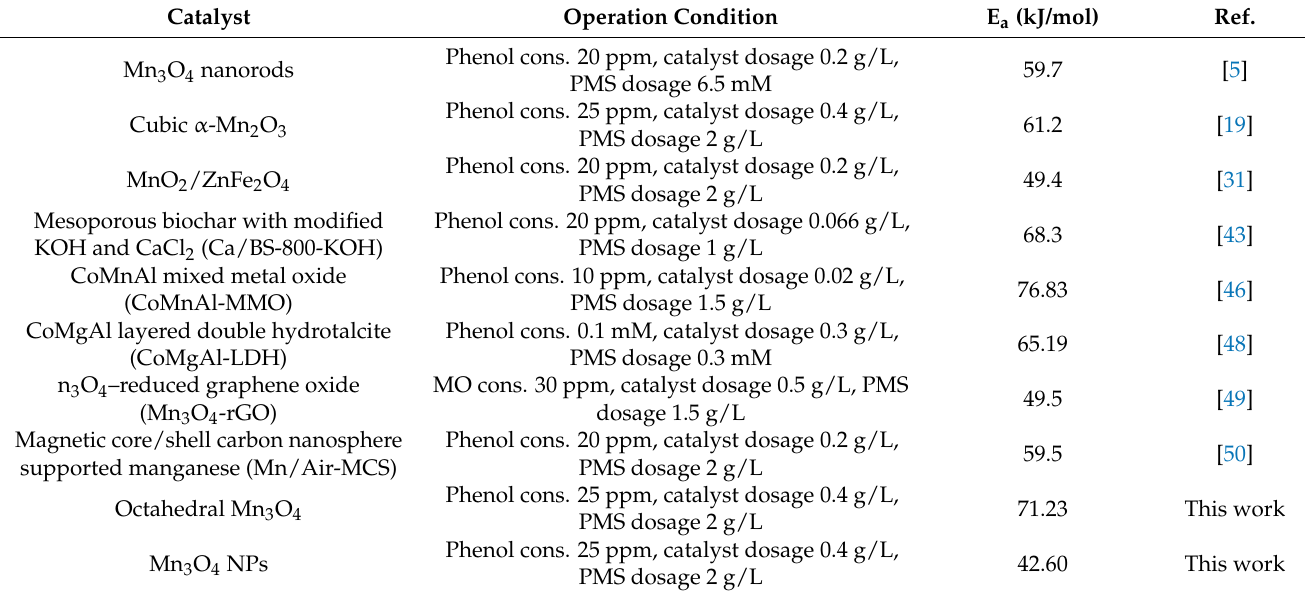
Table 3. Comparison of PMS activation using related catalysts for phenolic removal. Catalyst